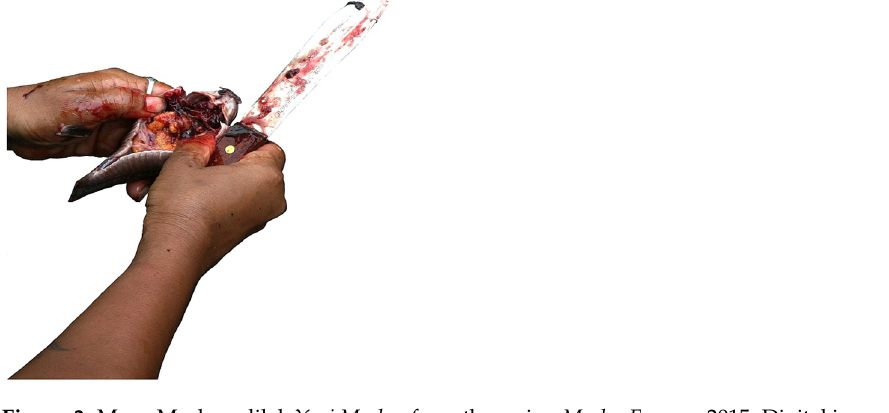
Figure 3. Maya Mackrandilal, Yoni Mudra , from the series, Mudra Erasure , 2015. Digital image/pigment print, 20 × 26 inches.